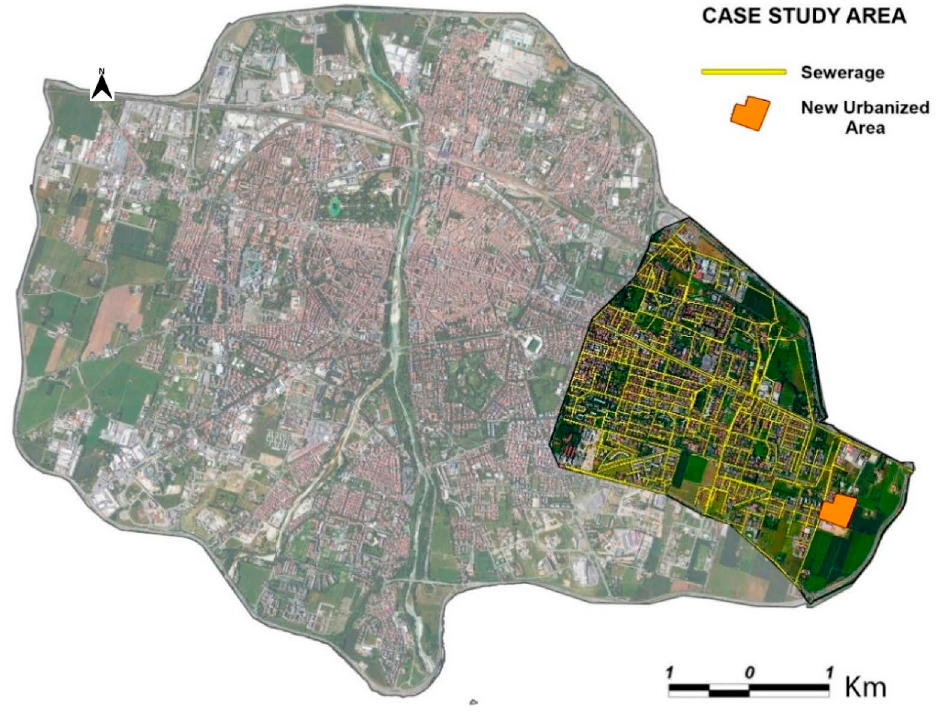
Figure 13. Case study area and sewerage.